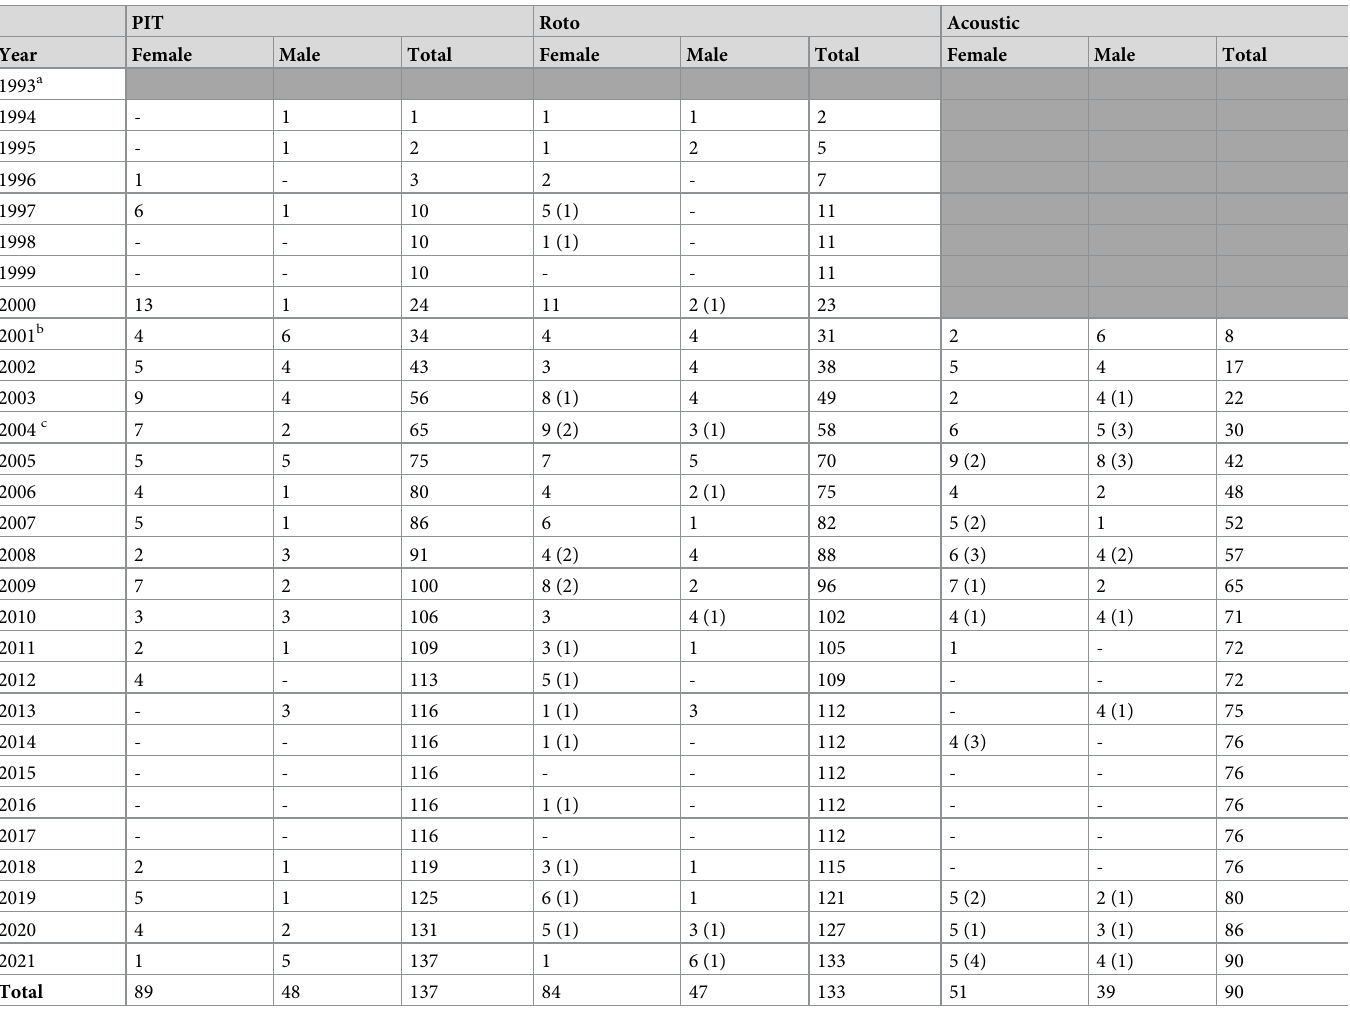
Table 1. Nurse shark tagging effort in the Dry Tortugas courtship and mating ground from 1993 to 2021. For each sex, the total number of tags (PIT, Roto tag, and acoustic transmitter) deployed each year, and the cumulative number of deployed tags (in italics) are provided. In addition, Roto and acoustic transmitter tags that were re-deployments (i.e., on animals that had previously been tagged) are provided inside parentheses for the respective year. These re-deployments were not included in the cumulative number of deployed tags. Dashes indicate instances where no sharks were tagged with a tag type deployed in a given year, whereas grey cells indicate years where certain tag types were not yet deployed in this